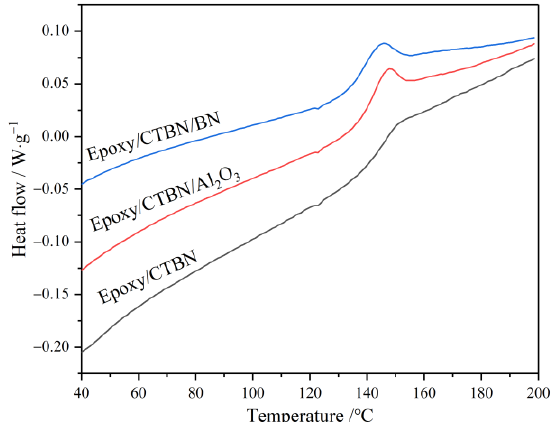
Figure 2. Heat flow curves of three kinds of samples obtained from DSC. Table 1. Glass transition temperature of four kinds of samples.